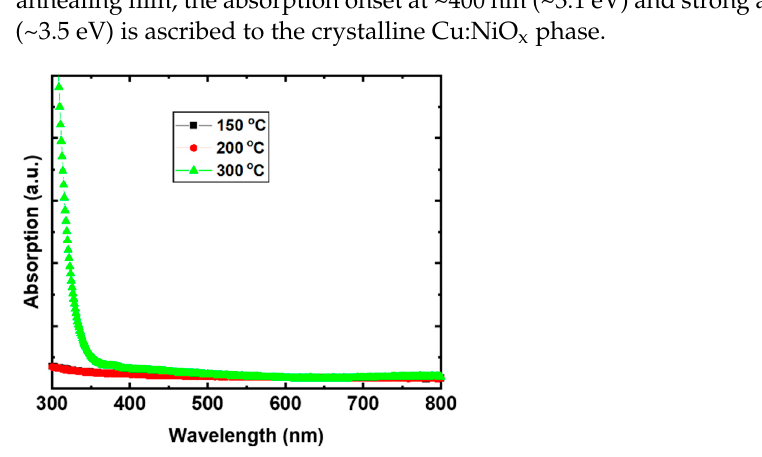
Figure 8. UV-Vis absorption of Cu:NiO x films fabricated on quartz substrates from precursor containing 0.1 molar ratio of fuel (Acac) to oxidizer (Cu, Ni nitrates) annealed at 150, 200, and 300 ◦ C. The contact angle of water was measured on films annealed at 150, 170, and 200 ◦ C, using a fuel to oxidizer ratio of 0 (w/o), 0.1, and 1.5 (see Supplementary Figure S2), from which the measured values are plotted in Figure 9. All the contact angles are higher than 60 ◦ , irrespective of fuel concentration, in contrast to the contact angle of the Cu:NiO x film (0.1 molar ratio of Acac to oxidizer) annealed at 300 ◦ C, which is substantially lower (20 ◦